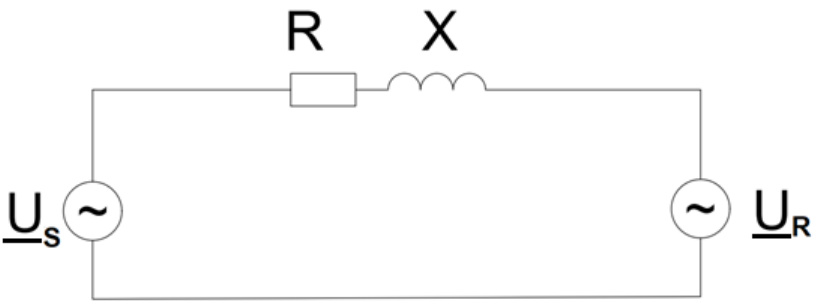
Figure 1. Simplified electrical scheme of the systems connected through the II-type line.